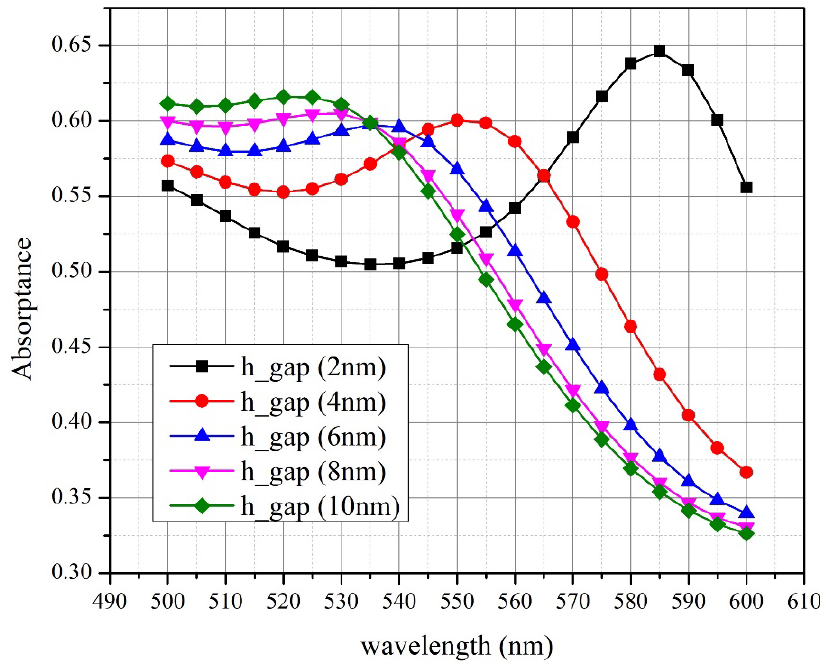
Figure 4. The absorptance spectrum of the structure with different gap layer thicknesses of 2, 4, 6, 8 and 10 (nm) and metal film thickness for all cases is 20 nm.